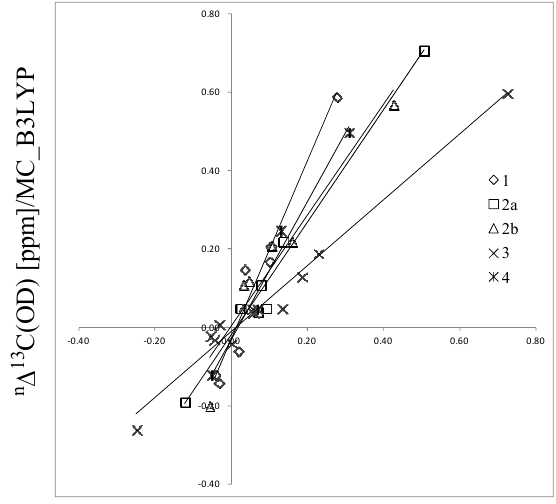
Figure 3. Calculated isotope effects using MC_B3LYP method plotted against the experimental